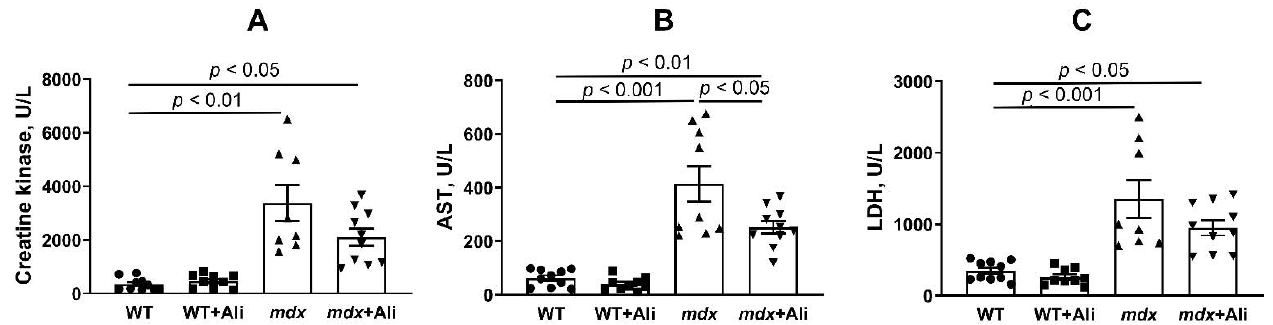
Figure 1. The effect of alisporivir treatment on the activity of creatine kinase ( A ), AST ( B ), and LDH ( C ) in the serum of experimental groups of mice. The data are presented as means ± SEM ( n = 8–10).